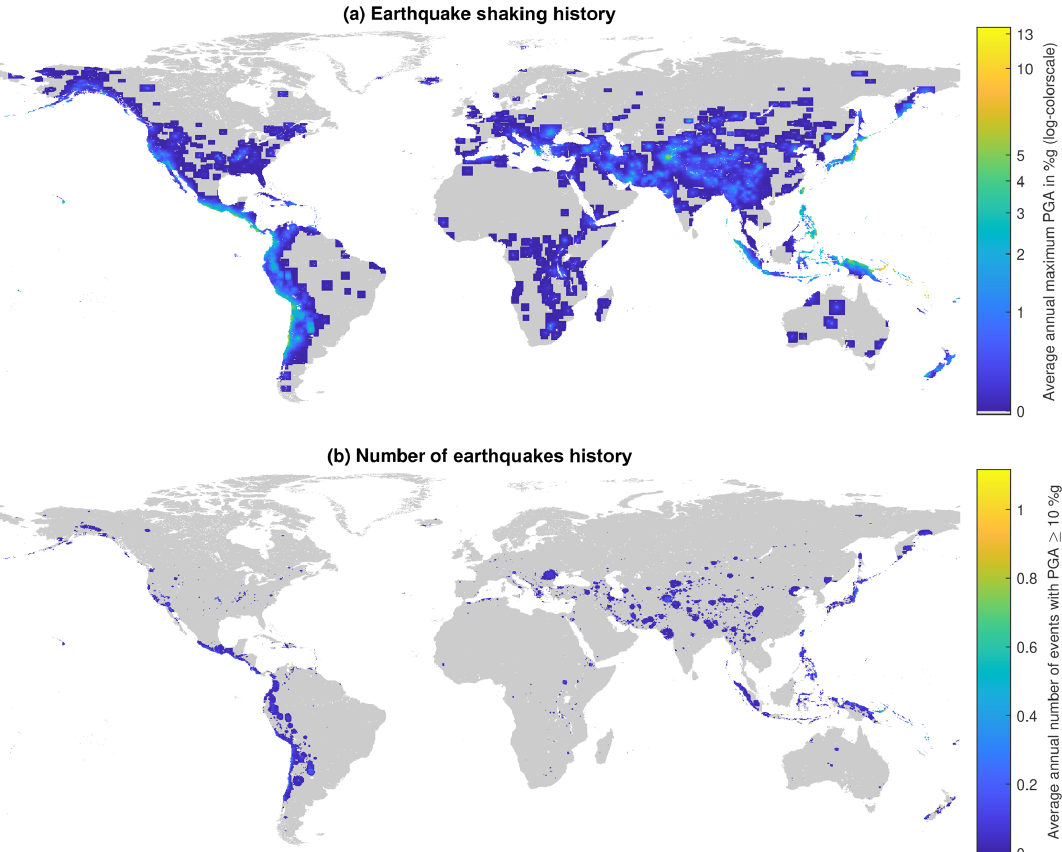
Figure 1. Earthquake shaking history of 1973–2015. Panel (a) shows the average annual maximum shaking exposure and panel (b) provides the average annual number of “big” shaking events by location. Panel (a) also illustrates some limitations of the data, such as the edges of individual ShakeMaps and an over-representation of low shaking events in more populated regions (e.g., Australia). It is also important to be aware that the shaking history is a combination of observed and estimated data for actual shaking exposure in the given time